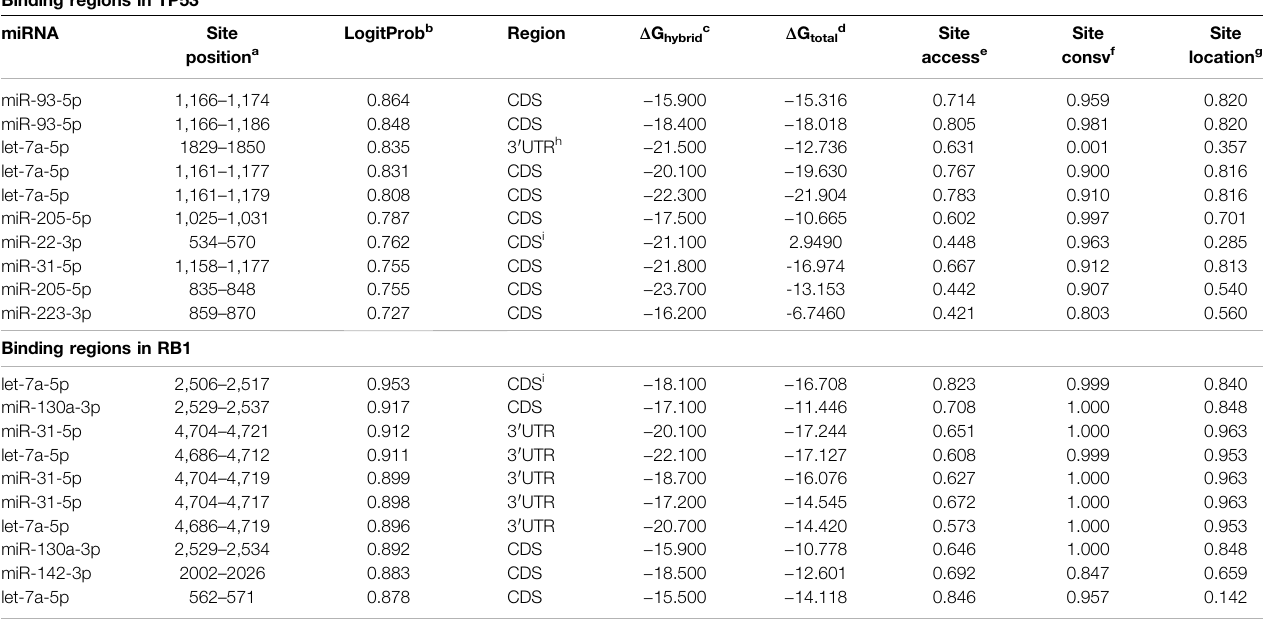
TABLE 3 | Top 10 miRNA binding regions identi fi ed in TP53 and RB1 genes. Binding regions in TP53